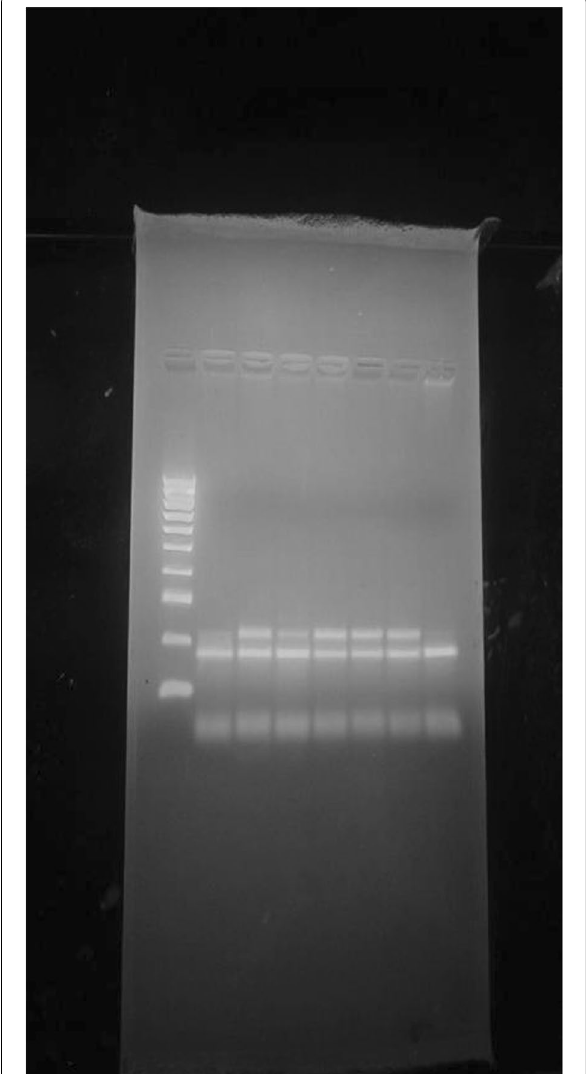
Fig. 1 Distribution of in PTPN22 C1858T genotype in diabetic patients and controls. Genotyping of PTPN22 from left: • Lane 1: DNA ladder 100bp. Band (T) at (218) bp Band (C) two fragments at (172) bp and (46) bp • Lane 2, and 8: Homozygous (CC genotype) only (C) band present. • Lane 3, 4, 5, 6, and 7: Heterozygous (TC) where both T band and C